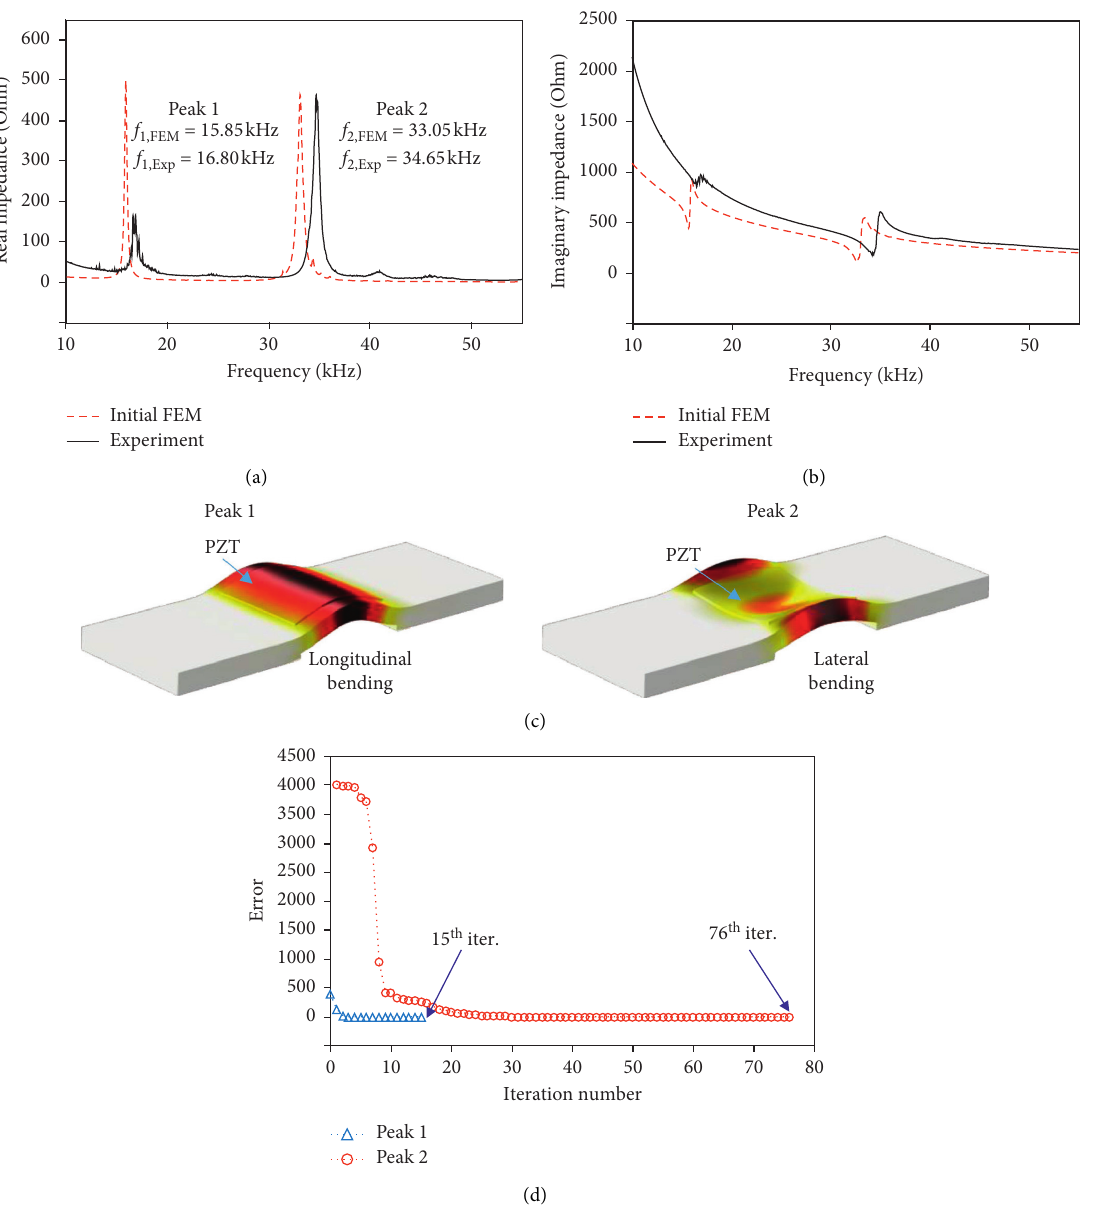
Figure 8: EMI responses of the initial FE model. (a) Real impedance. (b) Imaginary impedance. (c) Mode shapes. (d) Convergence progress of the FE